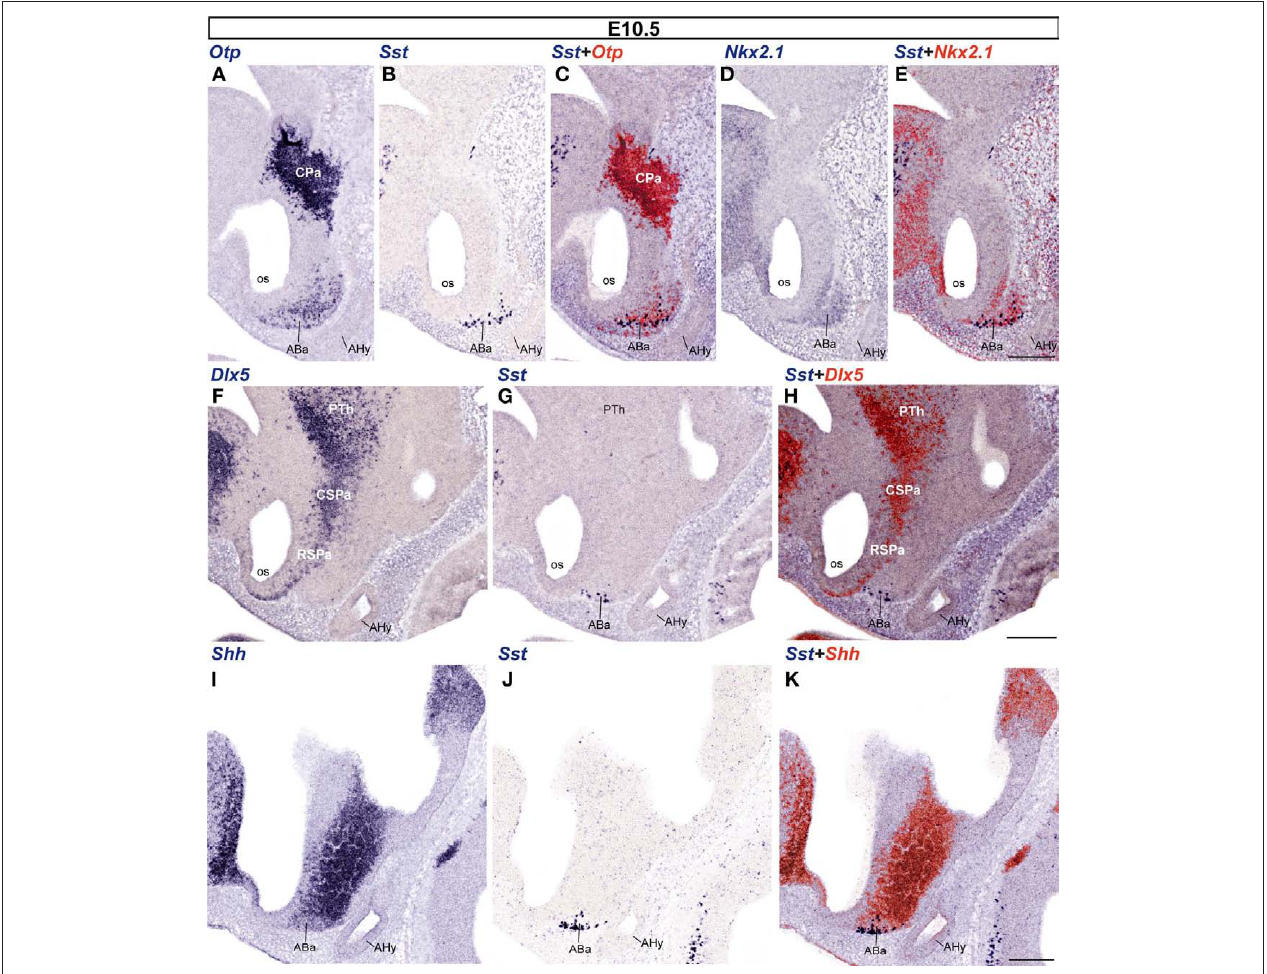
FIGure 3 | Sagittal sections of e10.5 embryos taken at lateral (A–e), intermediate (F–H), and medial (I–K) levels, correlating the indicated reference markers with the presence of sst -positive cells. Note the topographic coincidence of Sst signal with a larger surrounding population of Otp -positive cells. Bars = 200